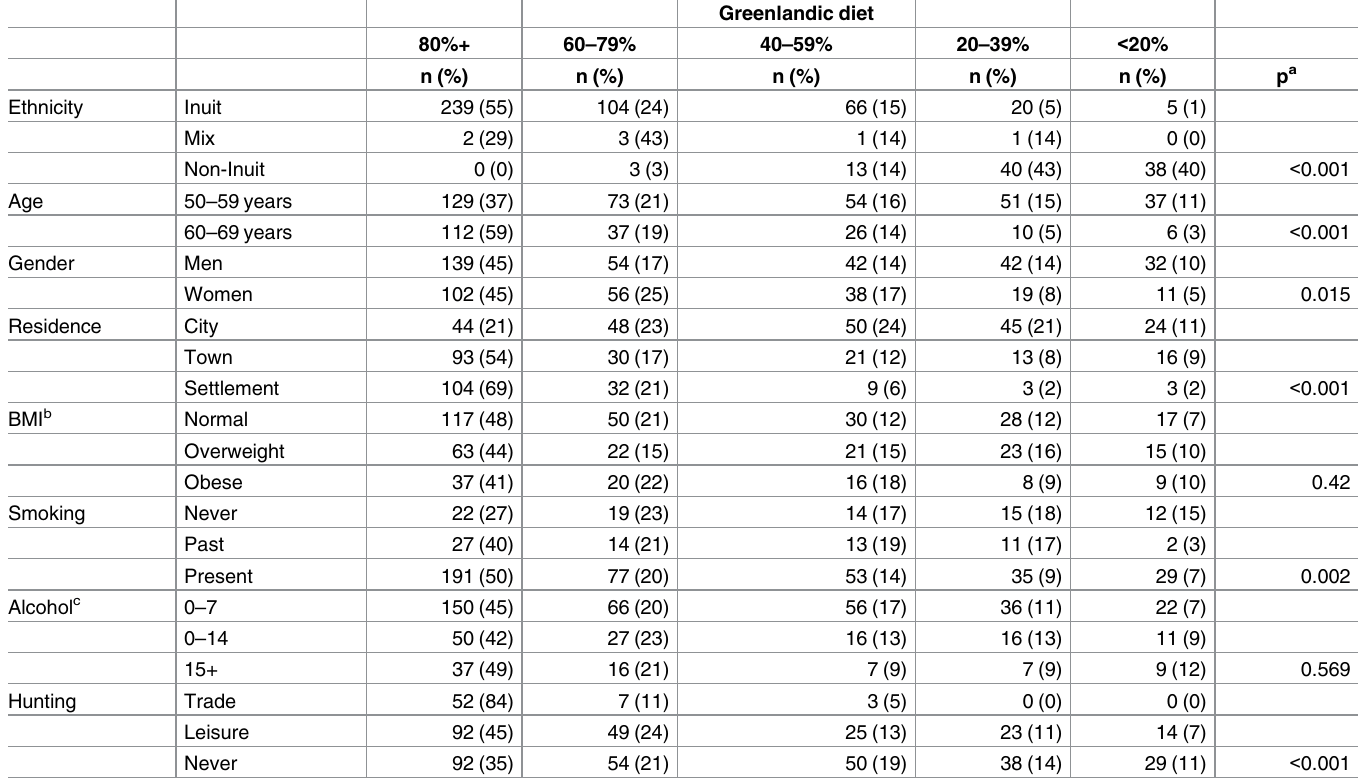
Table 1. Characteristics of the participants in the survey, based on intake of Greenlandic